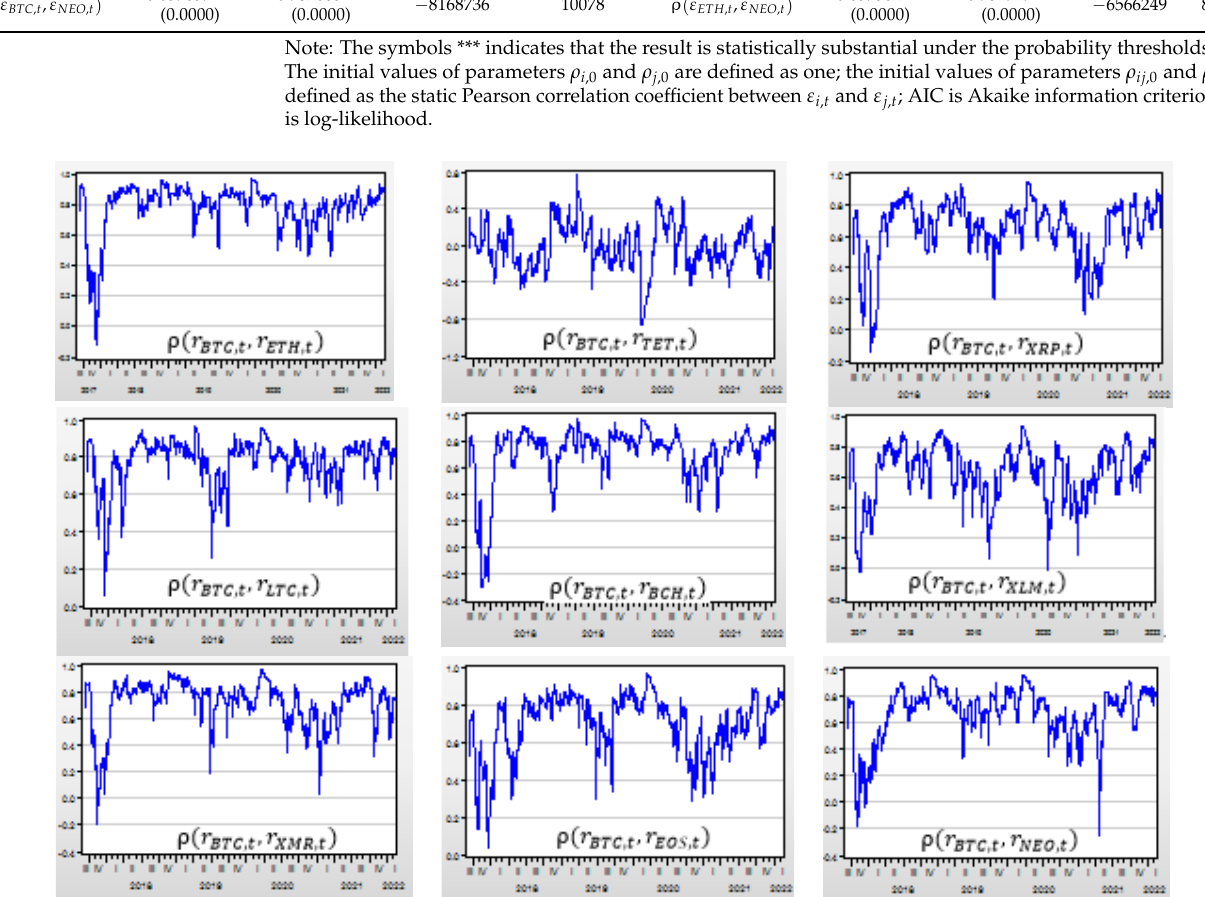
and the other cryptocurrencies were higher than the average values of the DCC between Bitcoin and the other cryptocurrencies. This means that Ethereum has become a more important representative cryptocur- rency than Bitcoin or that Ethereum has a higher impact on the other cryptocurrencies than Bitcoin.